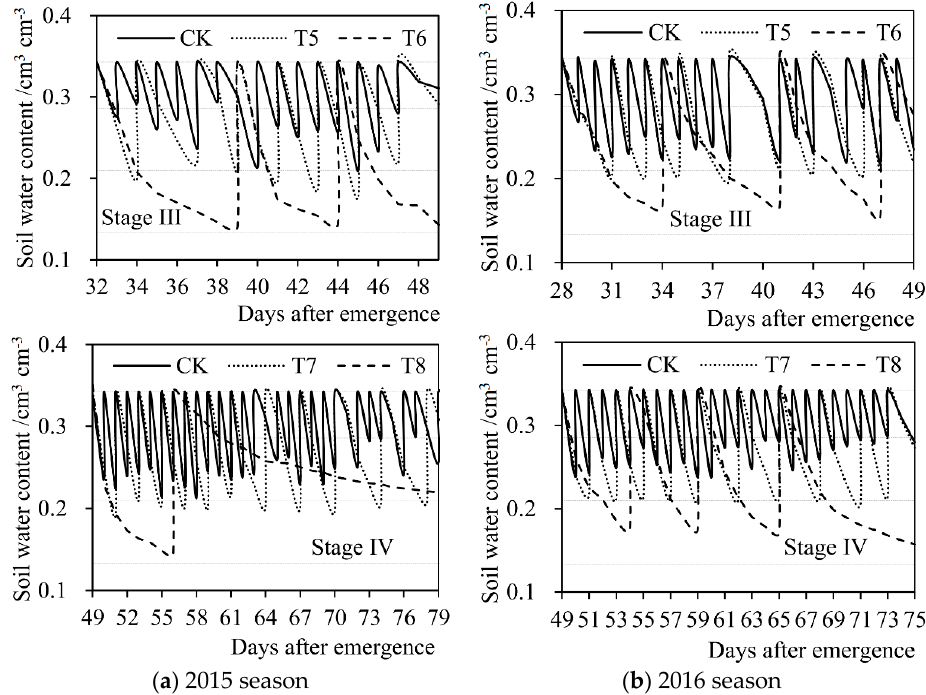
Figure 3. Daily soil water content of soybean pot during four growth stages under different treatments (T1–T8 and CK) in ( a ) the 2015 season and ( b ) the 2016 season. The constant horizontal dashed lines from top to bottom indicate the lower limits of no drought stress, mild drought stress, and severe drought stress, respectively. Stage I: seedling stage, Stage II: branching stage, Stage III: flowering-podding stage, Stage IV: seed filling stage. Volume water content (cm 3 × cm − 3 ) was converted from weight water content (g × g − 1 ) according to the density of water.